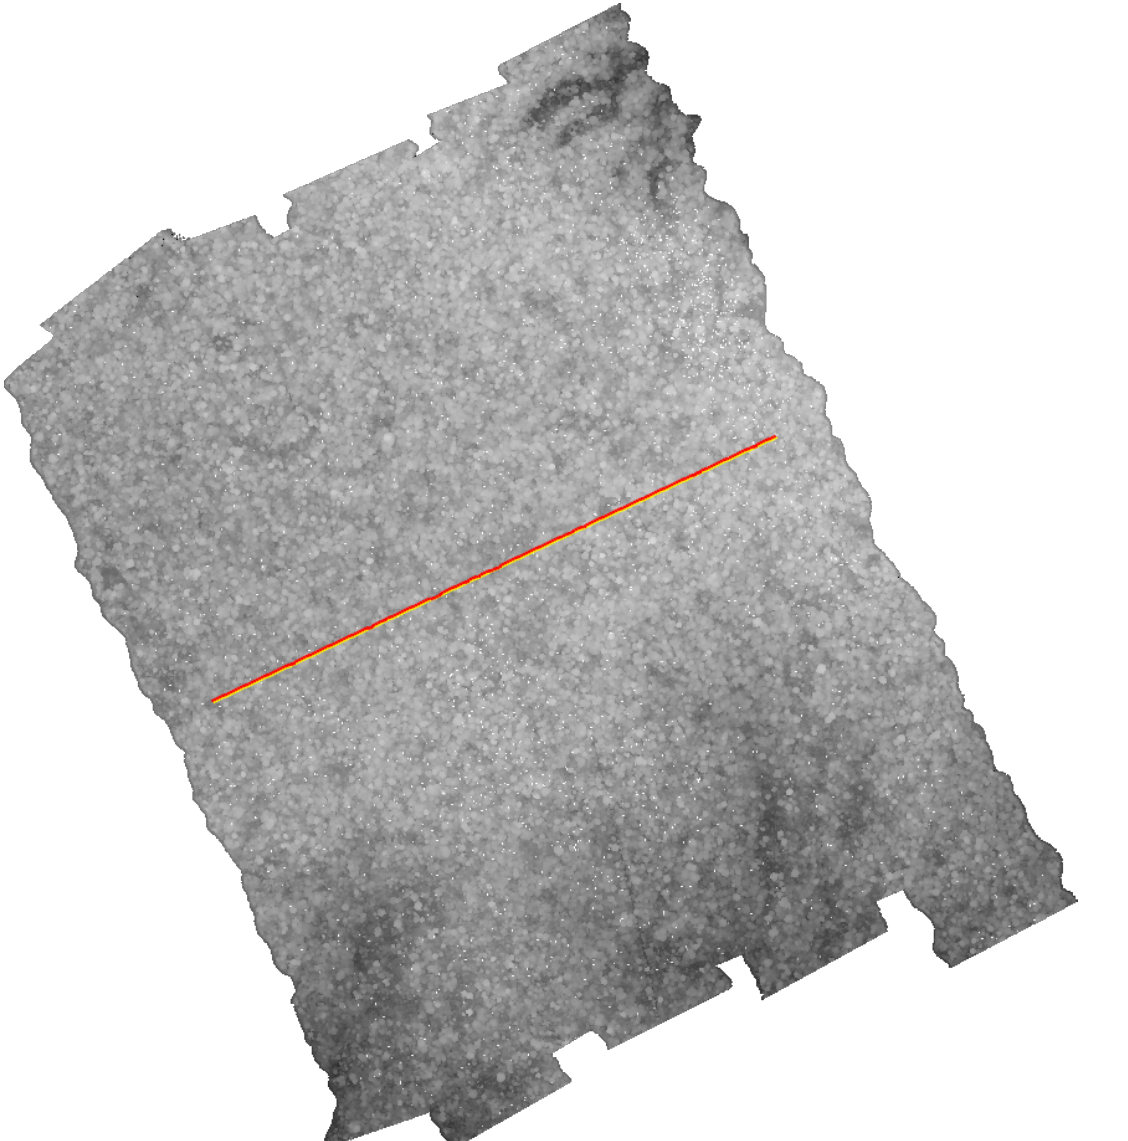
Figure 21. Trajectory in yellow on surface, circular bin, experiment. Corresponding estimated positions are drawn in